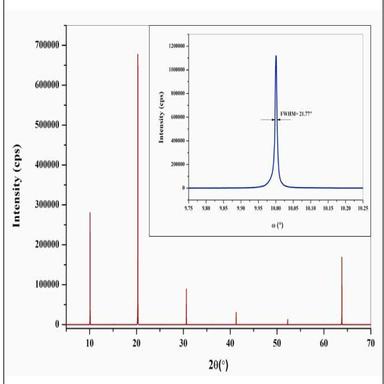
HRXRD 2θ/ω scan of GuHM crystal. Inset shows the rocking curve for the peak at 20.28◦.